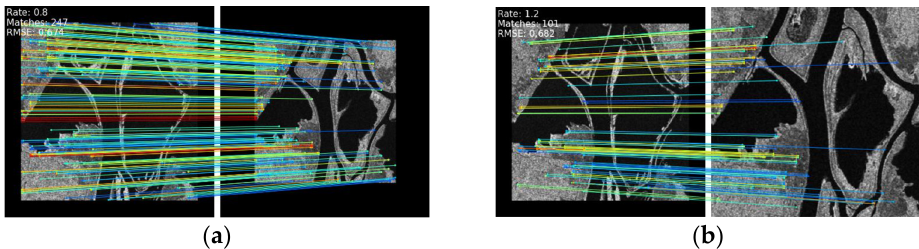
Figure 13. The registration performance of SAR images at varying sizes: ( a ) 0.8, and ( b )1.2.